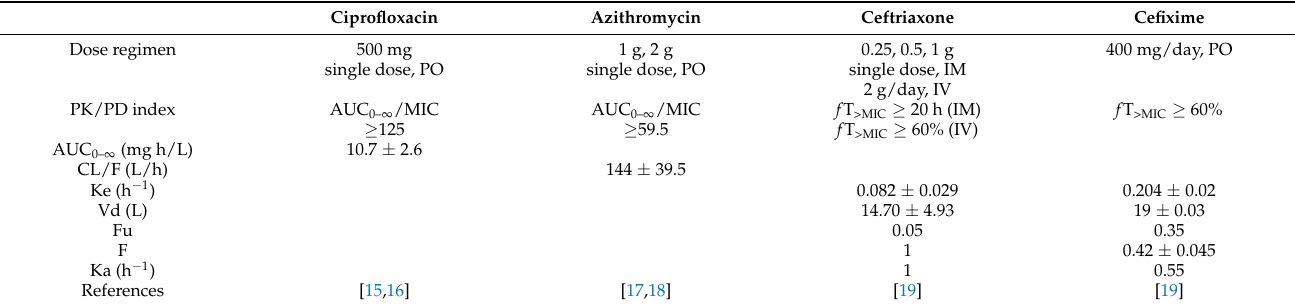
Table 1. Dose regimen, PK/PD index, and pharmacokinetic parameters used for